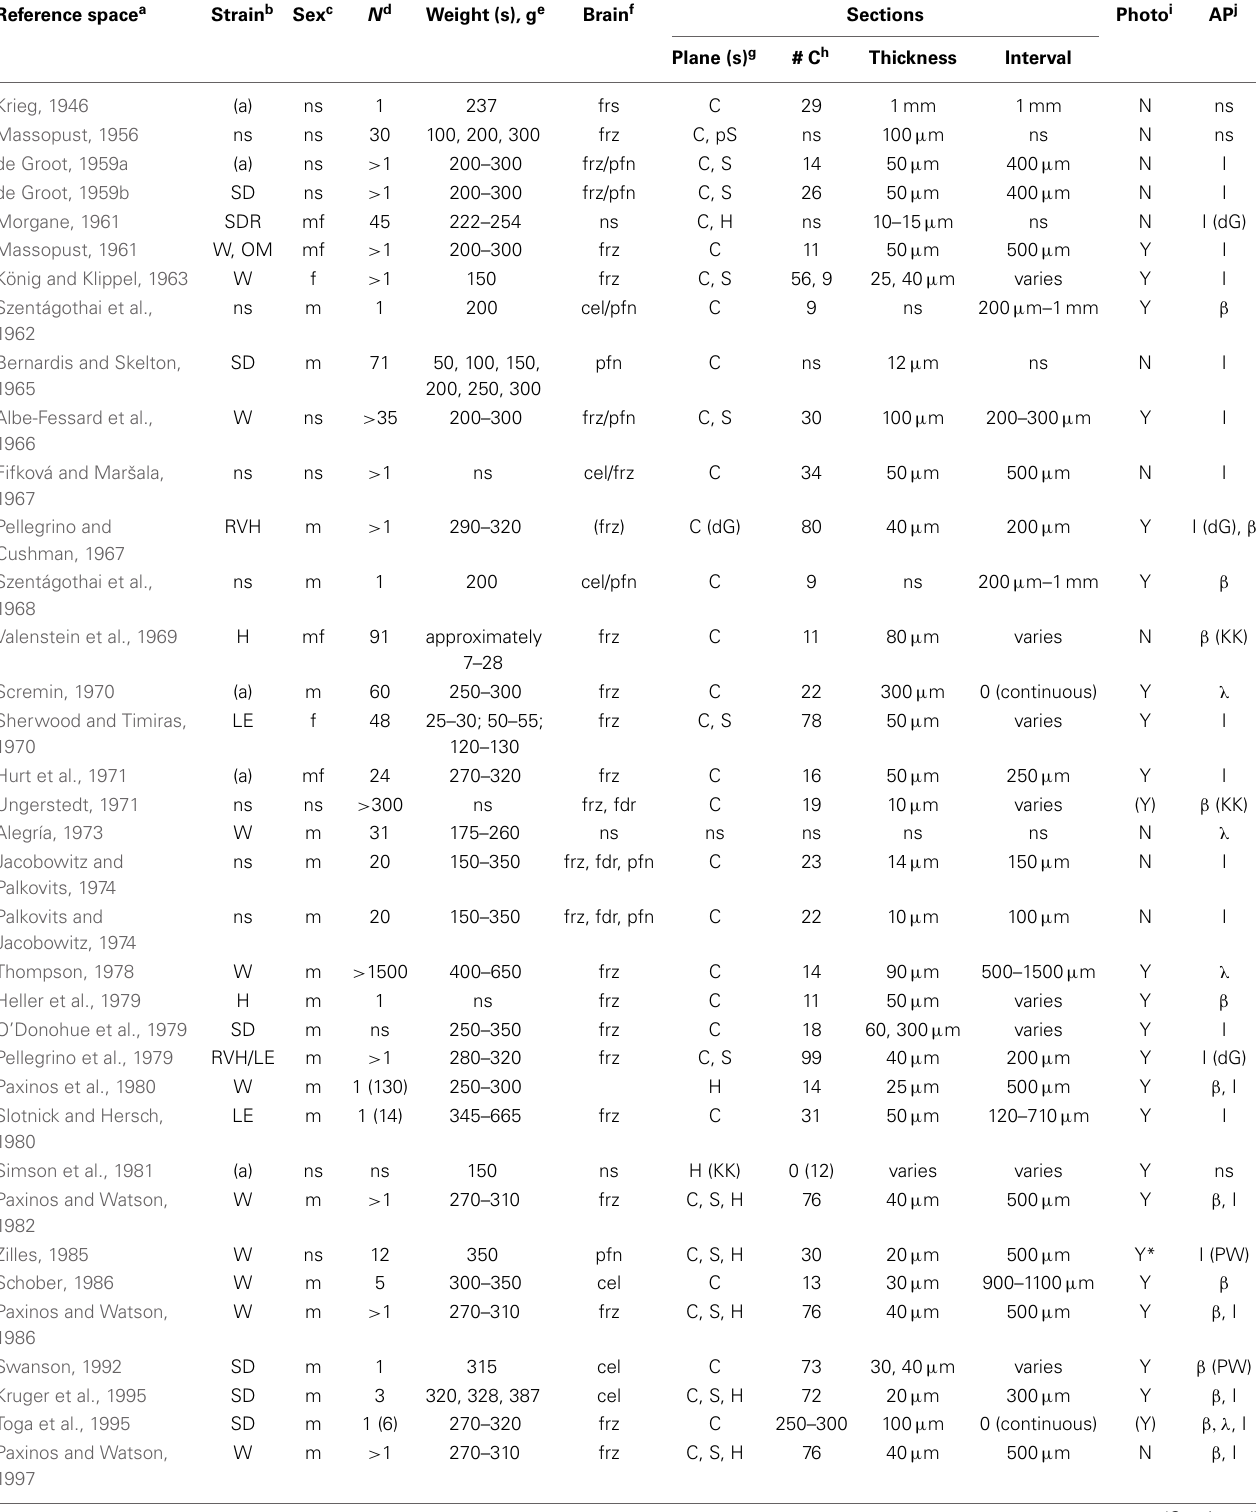
Table 4 | Reference spaces for the rat brain using coordinates in stereotaxic space. Reference space